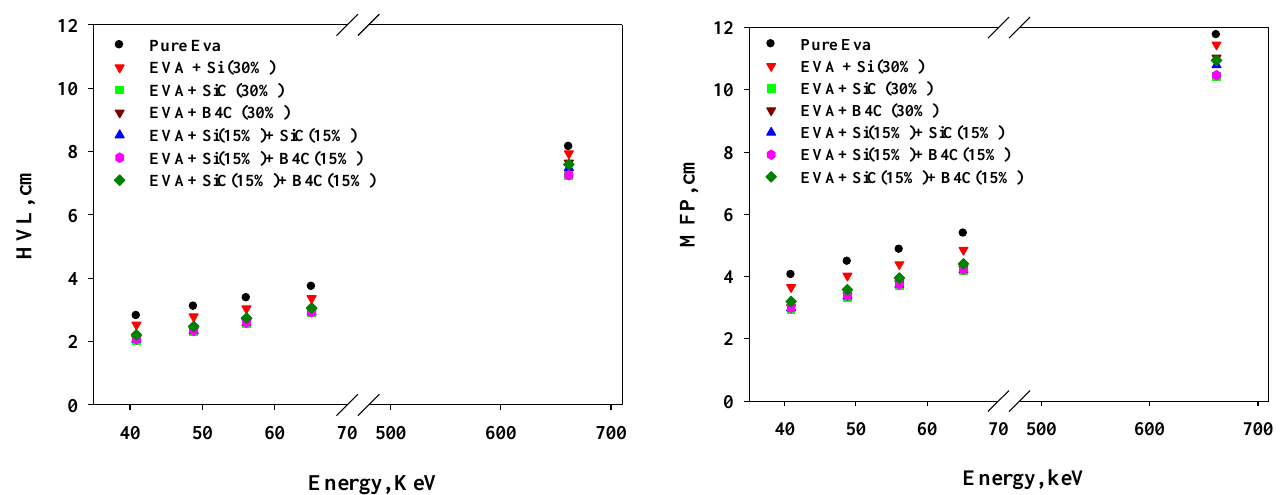
Figure 4. Variation of the measured HVL ( left ) and MFP ( right ) of the selected composite materials with the incident photon energies selected in this study.